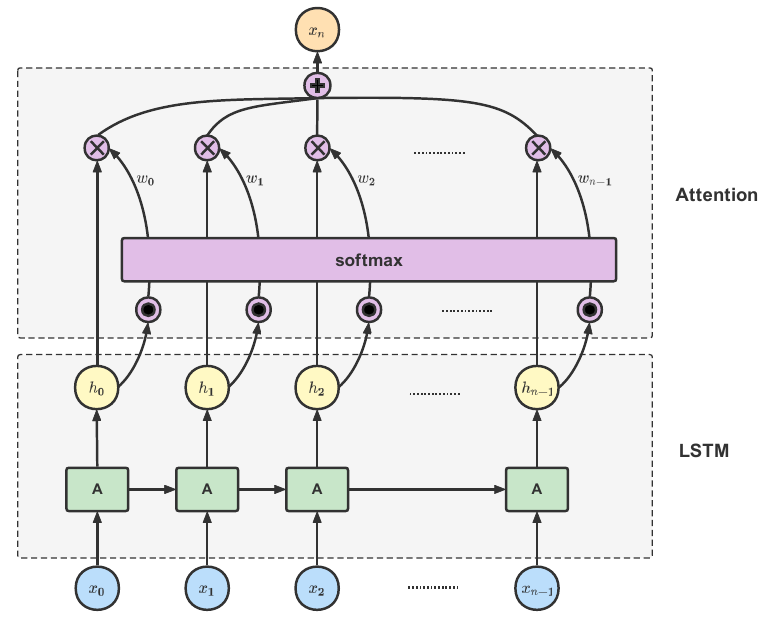
Figure 6. Prediction results using deep learning models.